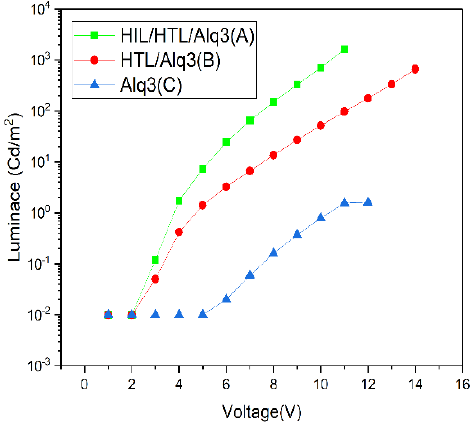
Figure 4. The curves of luminance and voltage characteristics with log-linear scale.